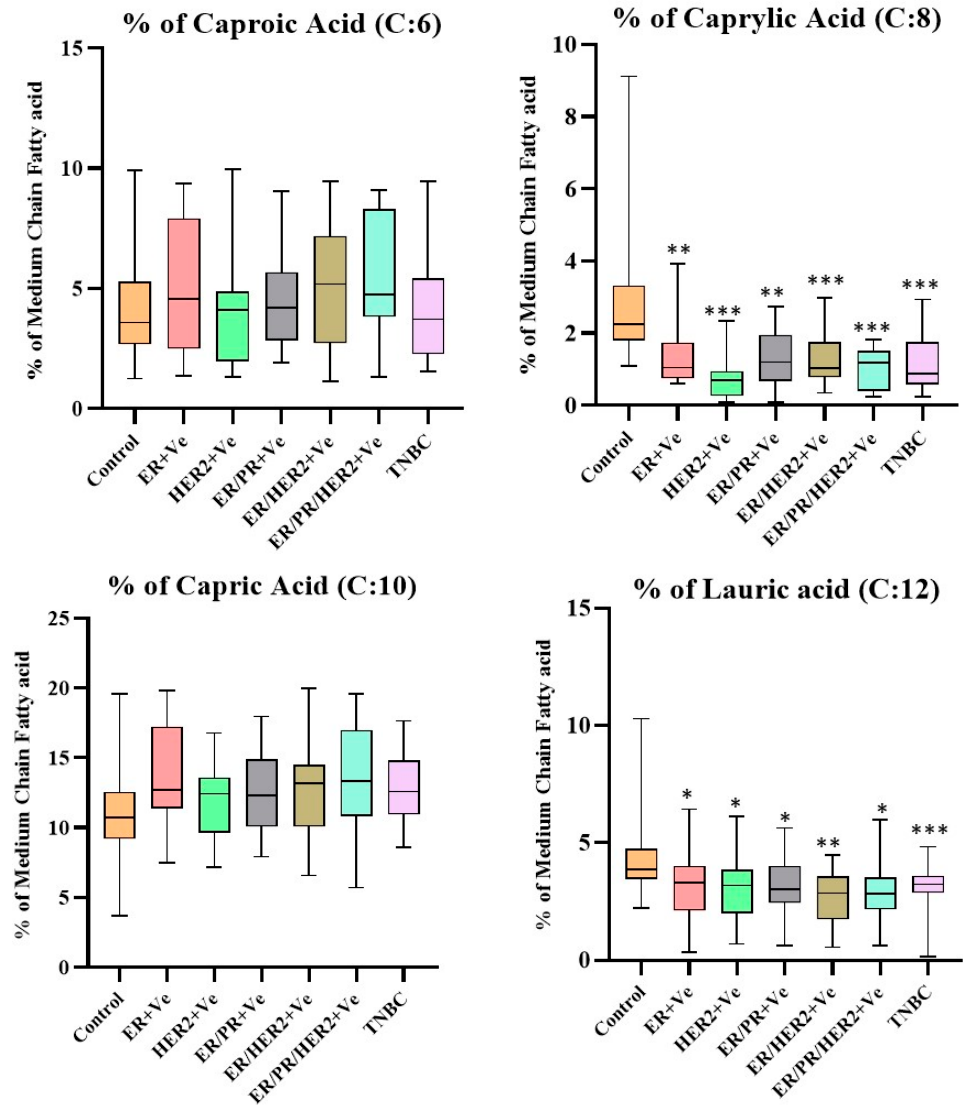
Figure 3. Tukey boxplots showing the distributions of the levels of each MCFA correspond- ing to various receptor statuses of breast cancer subjects. The quantity of each MCFA was cal- culated as a % of total MCFAs. p value was calculated using Mann–Whitney U test for non- parametric variables. ER + Ve ( n = 17), HER2 + Ve ( n = 18), ER/PR + Ve ( n = 16), ER/HER2 + Ve ( n = 18), ER/PR/HER2 + Ve ( n = 15), and TNBC ( n = 16). *** p < 0.0001, ** p < 0.001,